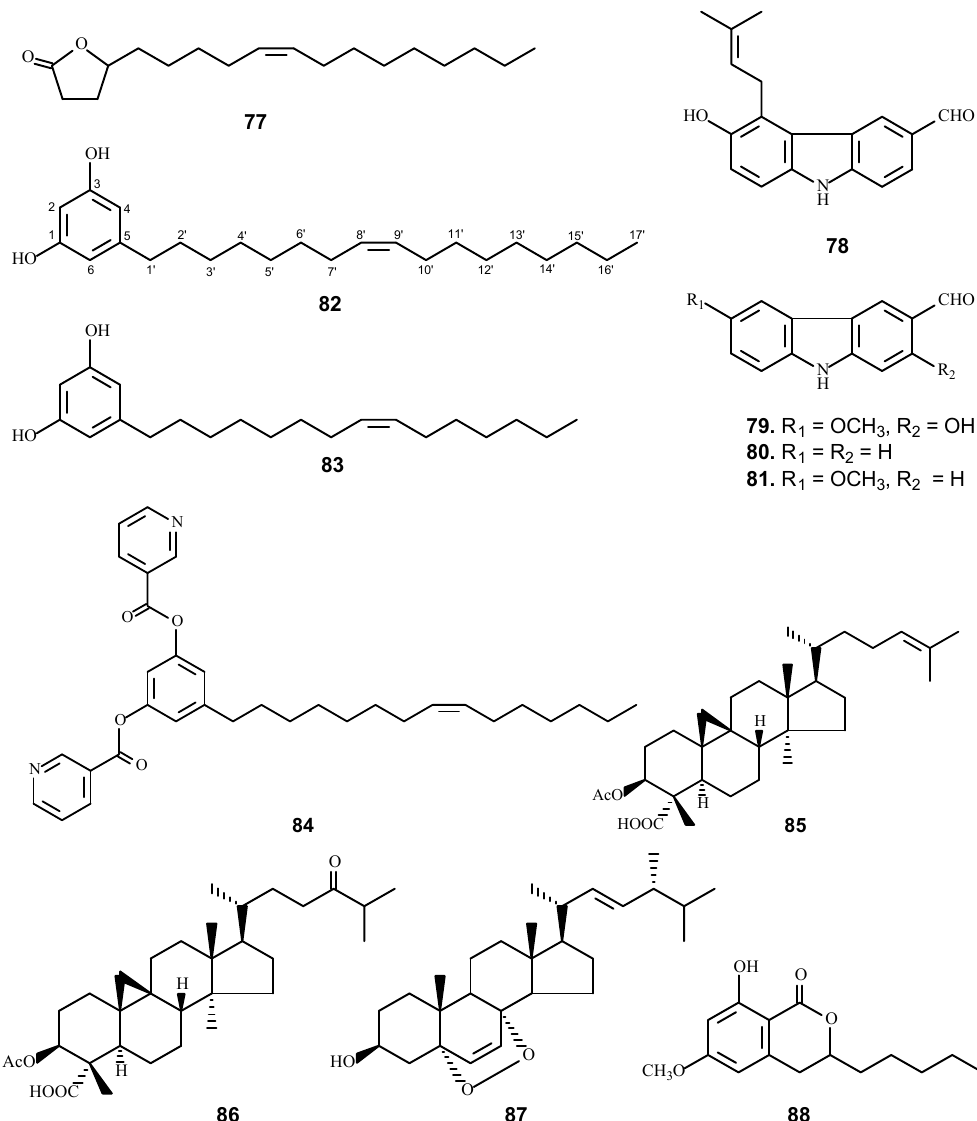
Figure 3. The chemical structures of compounds 77 – 88 .